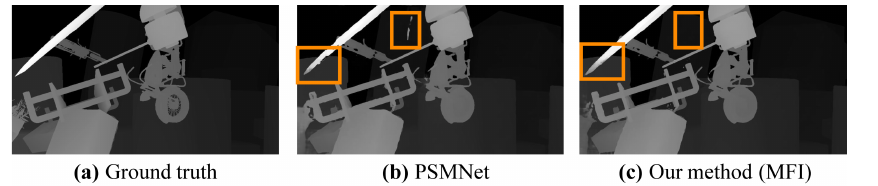
Figure 8. Qualitative result of MFI. ( a ) is the ground truth, ( b ) is the result of the baseline model, and ( c ) is the disparity result of our method with multiple frequency inputs.